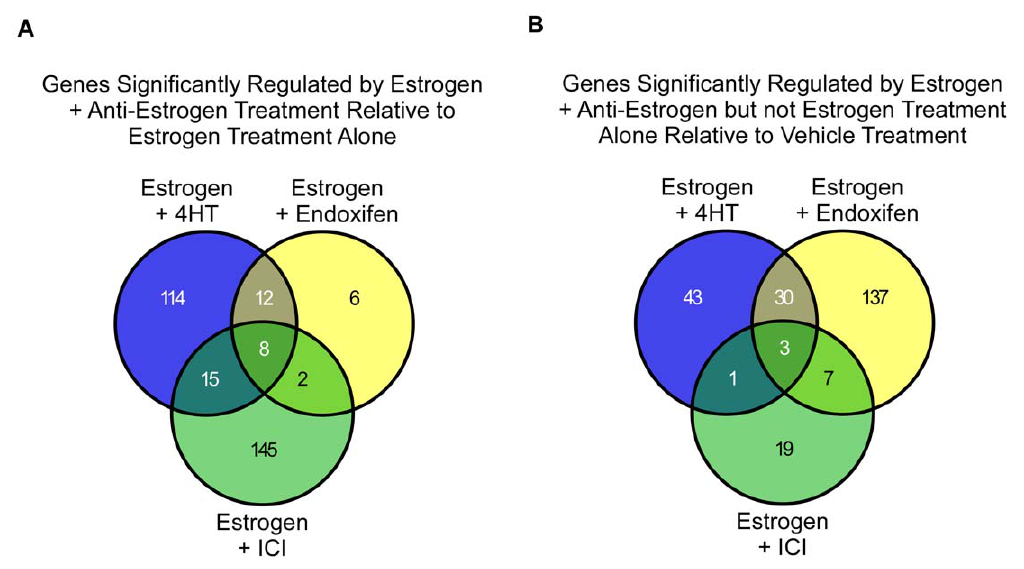
Figure 4. Venn diagrams depicting the anti-estrogen specific effects on estrogen-dependent and -independent genes. ( A ) Venn of genes whose expression levels were significantly altered by 1.5 fold or greater in MCF7 cells treated with 10 nM estrogen plus 100 nM concentrations of indicated anti-estrogens, relative to cells treated with estrogen alone following 24 hours of exposure. ( B ) Venn diagram of genes whose expression levels were significantly altered by 1.5 fold or greater in MCF7 cells treated with 10 nM estrogen plus 100 nM concentrations of indicated anti- estrogens, but not by estrogen treatment alone, relative to vehicle treated controls following 24 hours of exposure.